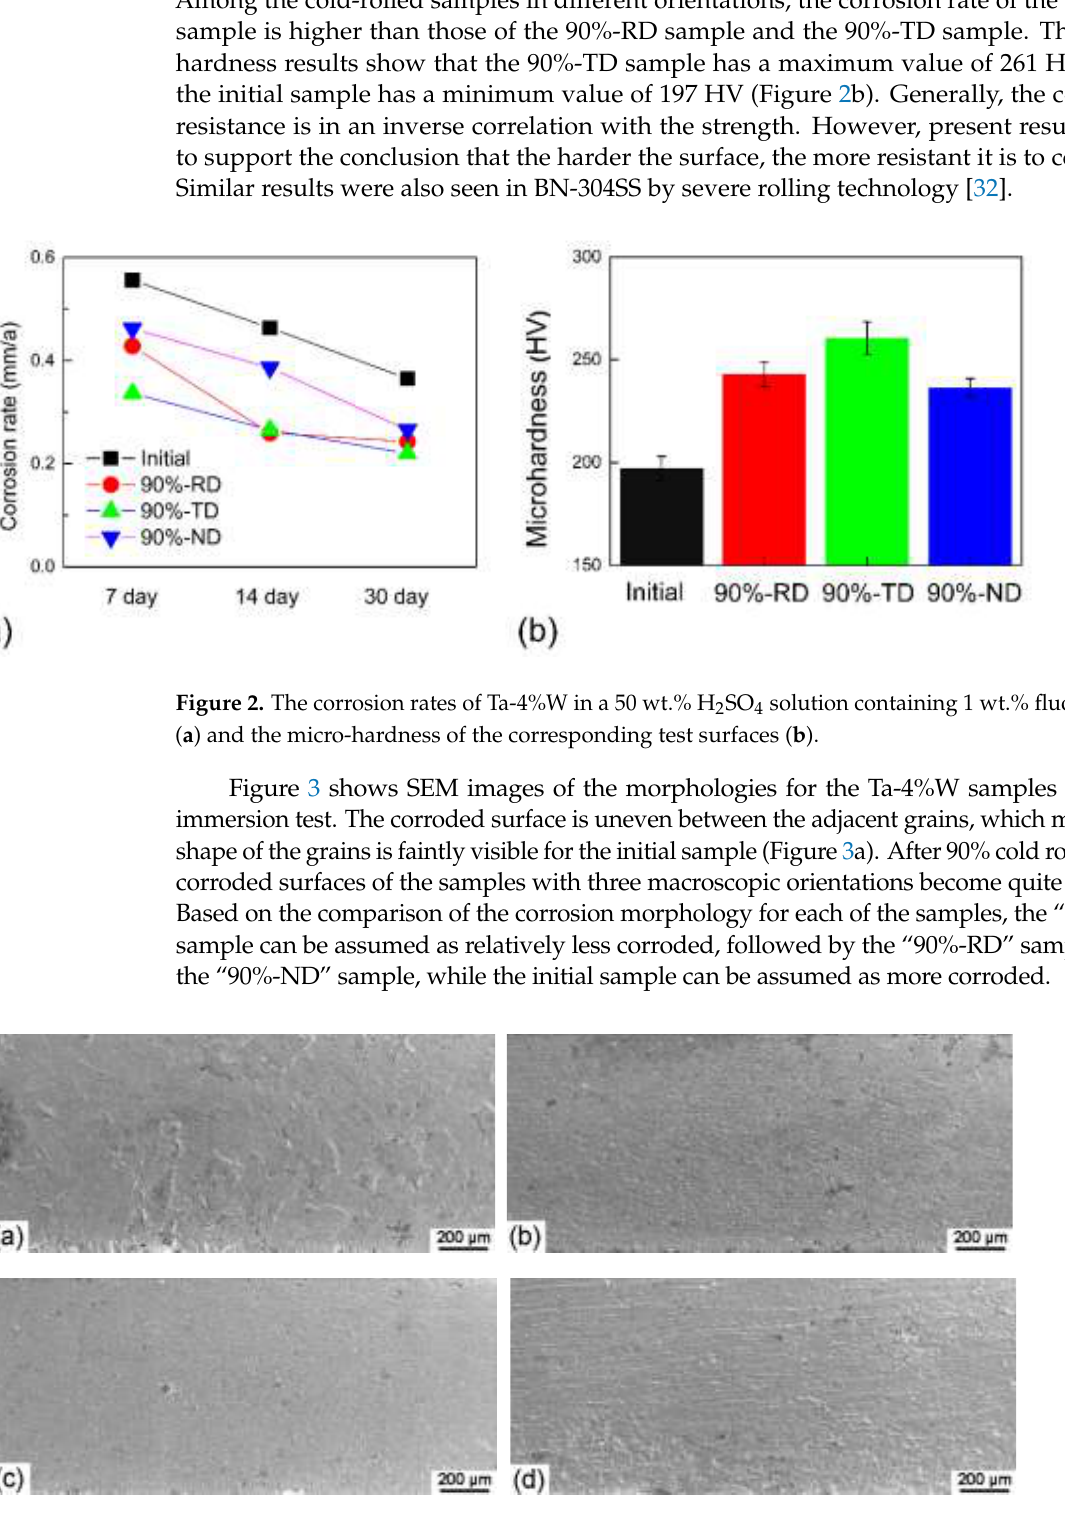
Figure 3. SEM images of the Ta-4%W corrosion samples after 30 days of immersion testing: ( a ) “in- itial” sample, ( b ) “90% -RD ” sample, ( c ) “90% - TD” sample , and ( d ) “90% - ND” sample. sample, ( b ) “90%-RD” sample, ( c ) “90%-TD” sample, and ( d ) “90%-ND”